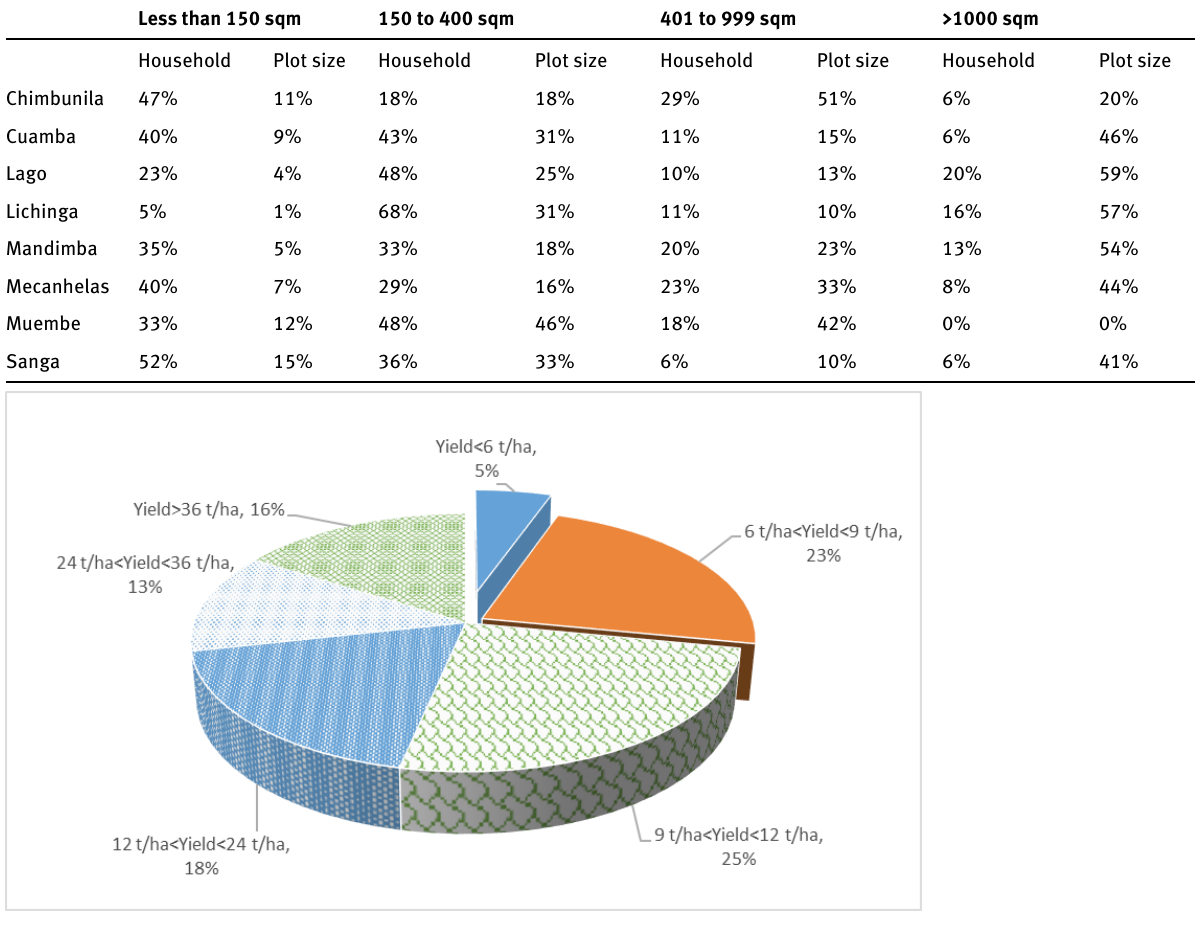
Figure 9: Root yield repartition